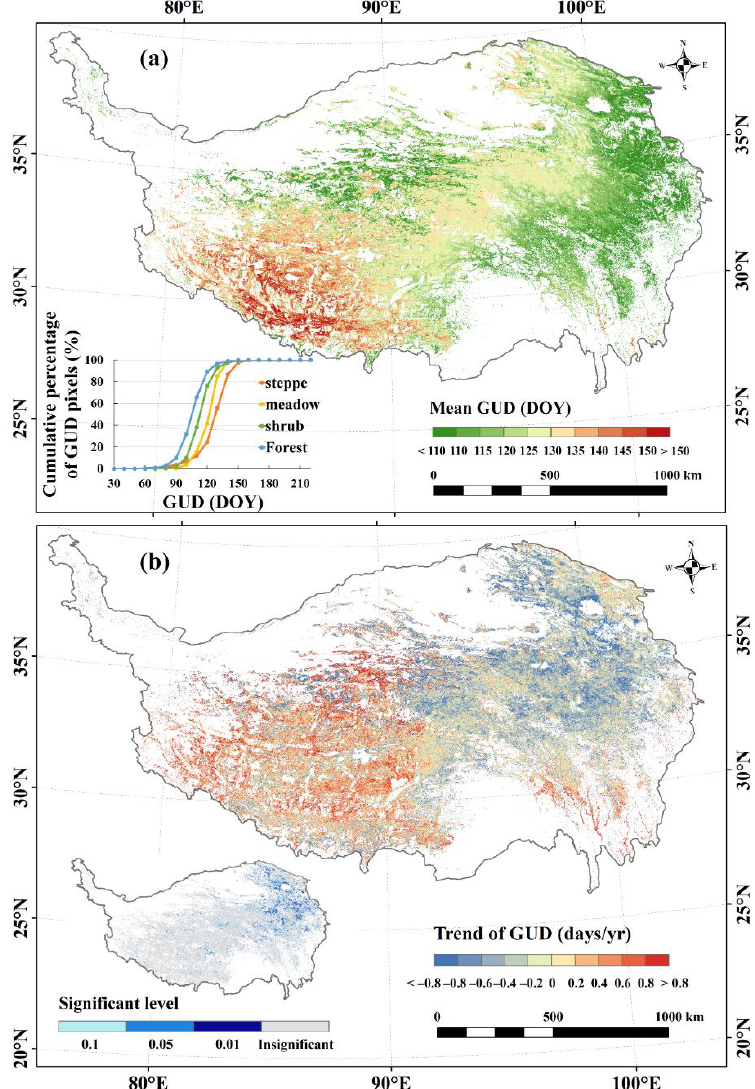
Figure 3. The spatiotemporal variation in GUD during 2003 – 2020. ( a ) Spatial distribution of annual mean GUD. The line chart in the lower left displays the cumulative percentage of GUD pixels for the four vegetation types. ( b ) Interannual variation trend of GUD. The map in the lower left shows the significant level of the trend. DOY, day of year.